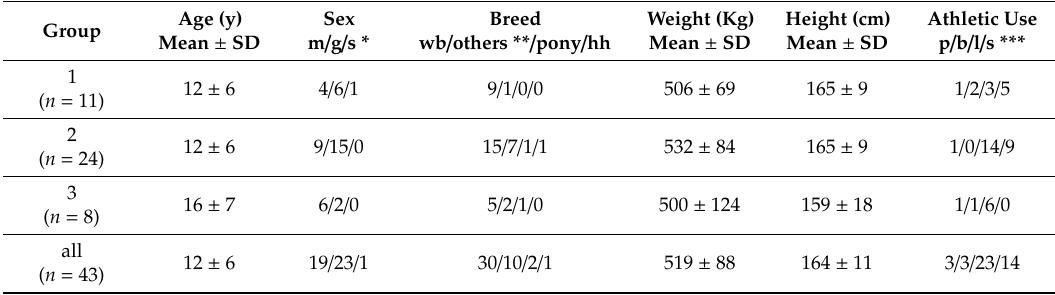
Table 1. Demographic data of the study population, including age, sex, breed, weight and height, and athletic use of the horses in each treatment group.